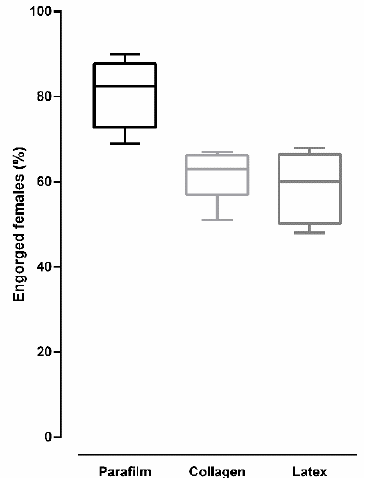
Figure 5. Weight-increase ratio after Aedes aegypti females were artificially blood-fed using different membranes. (Bars = ±SEM).